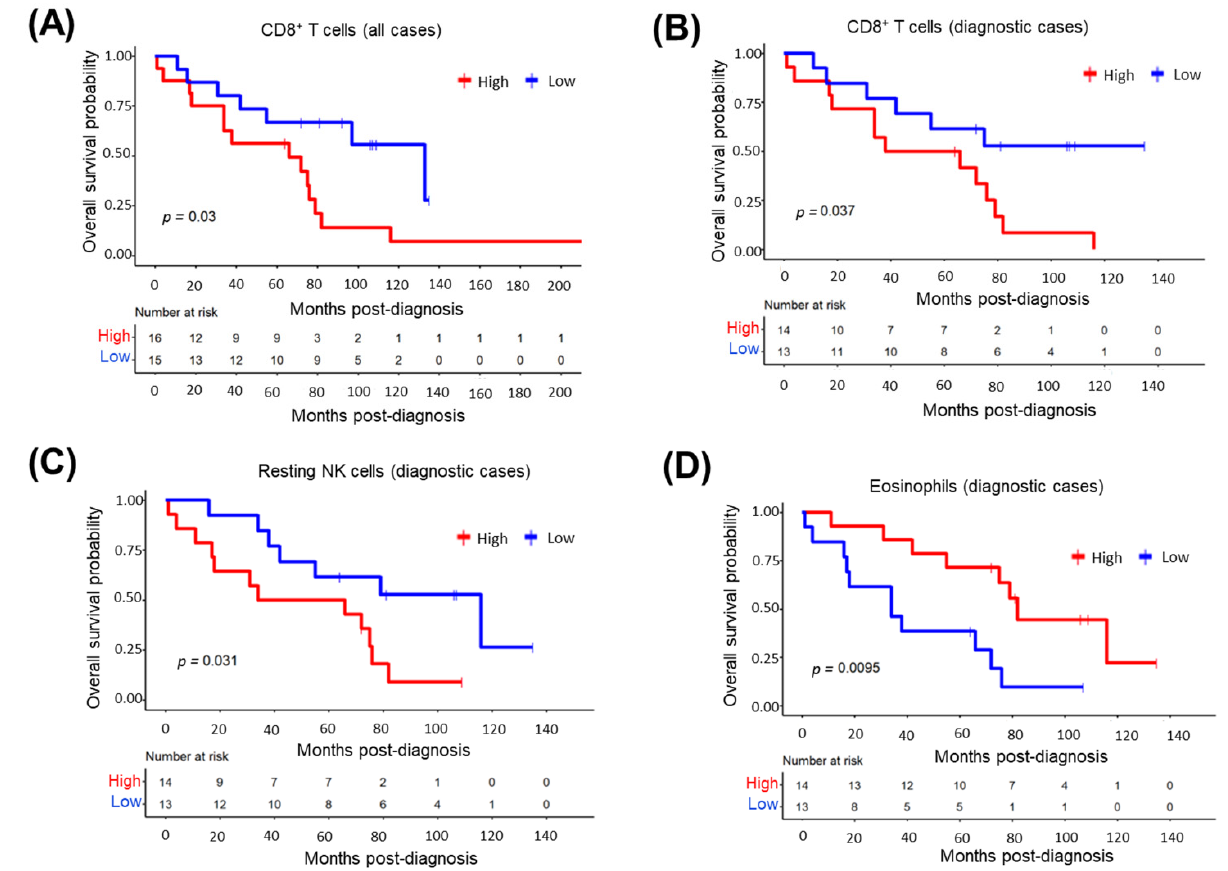
Figure 10. Microenvironmental immunocytes associated with overall survival of MCL patients. Kaplan-Meier plots show the tumor-infiltrating immunocytes that are associated with poor ( A – C ) or good ( D ) overall survival. High: High ratio of the immune cell. Low: Low ratio of the immune cell. All cases: 27 diagnostic and 4 relapsed MCL.